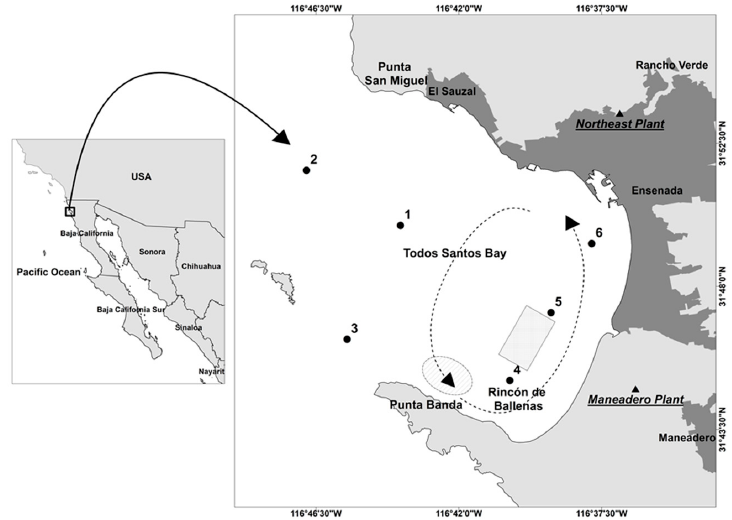
Figure 1. Study area, Todos Santos Bay (Baja California, Mexico). Points from 1 to 6 are field stations. The rectangle shows a bivalve mollusks cultivation area and the oval a tuna fattening area. Dashed lines and arrows indicate predominant circulation